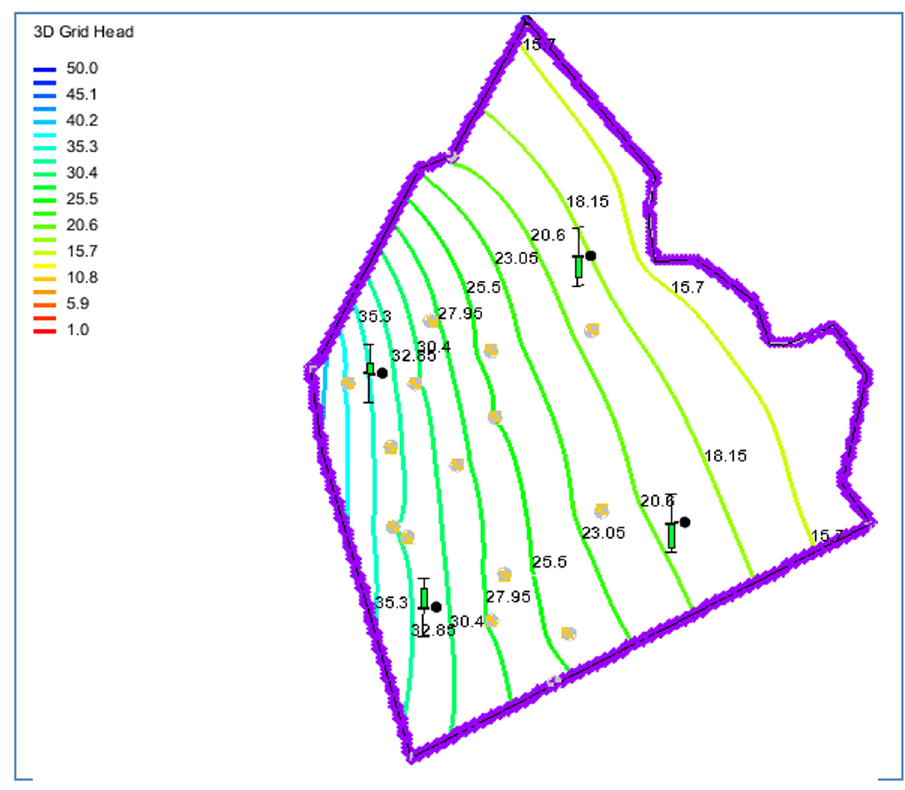
Figure 5: Starting head and boundary condition for Al - Ruhbah